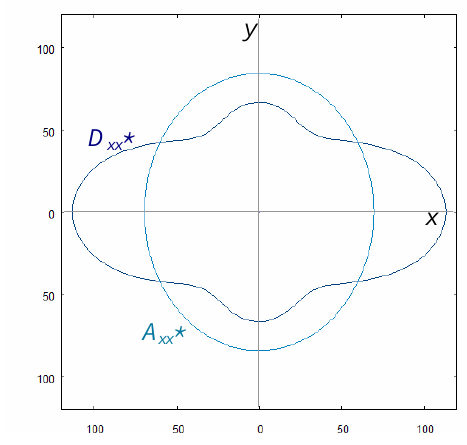
* and D * ( B *  0) for example 3 xx xx xx